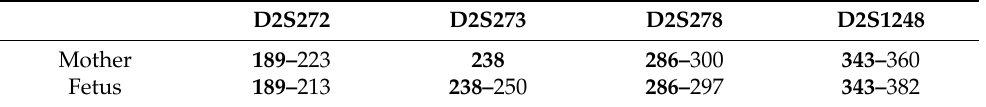
Table 2. Maternal and fetal STR markers selected for uniparental disomy (UPD)